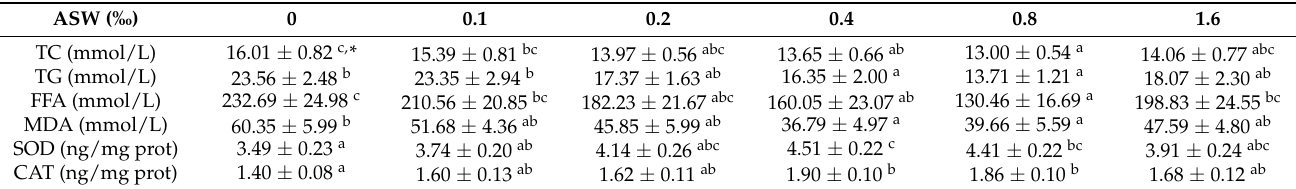
Table 6. Effect of ASW on liver lipids and antioxidant enzymes in GIFT (mean ±